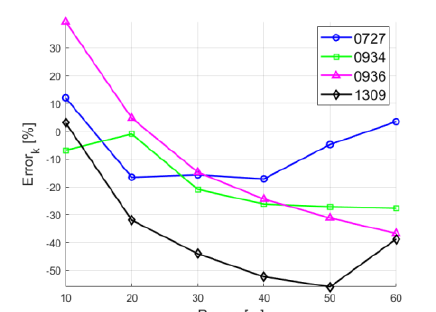
Fig. 5. Mean relative difference of Grasselli parameters ( 𝑒𝑟𝑟𝑜𝑟 𝑘 ) for range denoised TLS surfaces using SWT with global penalised high threshold of the four samples versus